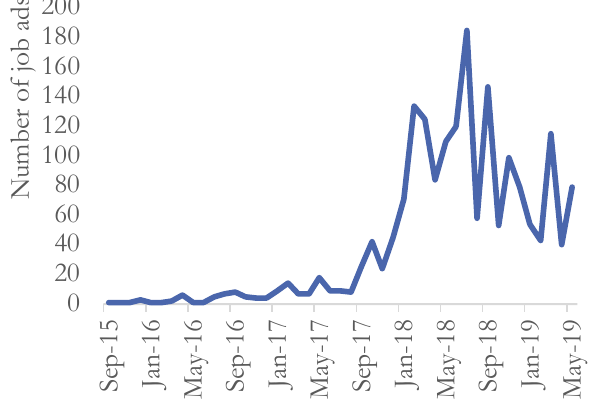
Figure 3. Blockchain-related online jobs ads in Australia by month,